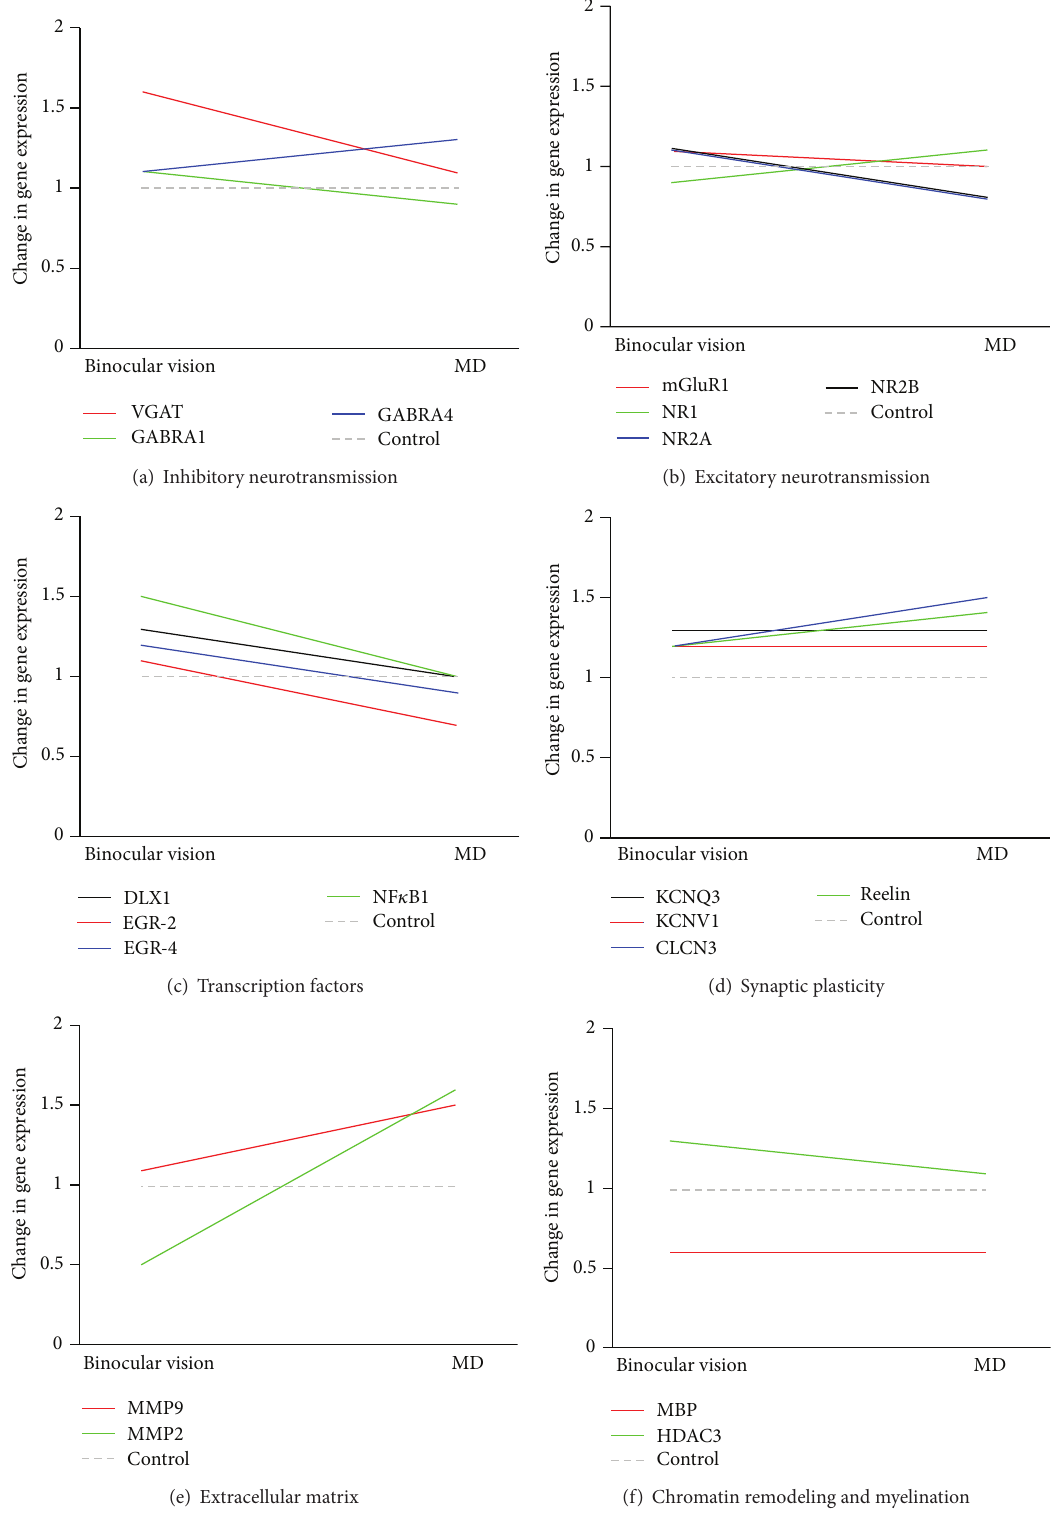
Figure 2: Effects of fluoxetine in the expression of genes involved in critical period plasticity. qRT-PCR mRNA fold change comparison between the effects of fluoxetine in rats with binocular vision and monocular deprivation. Statistical data is grouped by binocular vision or monocular deprivation, and in each part the position of the line represents the fold change of the fluoxetine treated group (coloured line) with respect to the saline treated group (grey dashed line) (BV-Sal versus BV-Flx and MD-Sal versus MD-Flx, resp.). All gene expression was normalized using GAPDH as a control